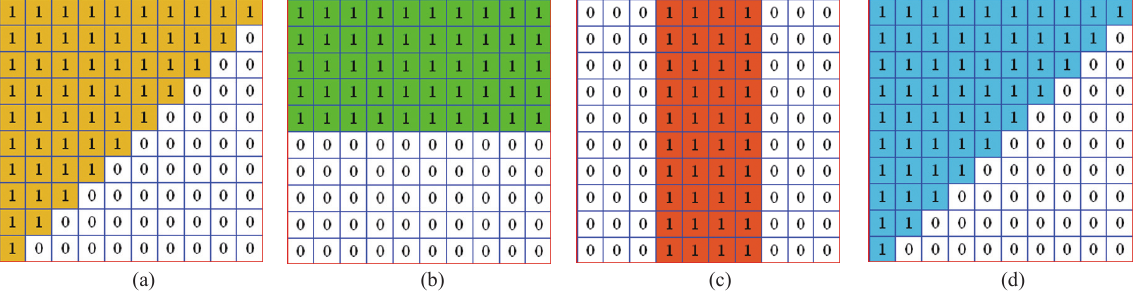
Fig. 3. Data gridding results of the fault template and the test sample (a) Sample 1 (b) Sample 2 (c) Sample 3 (d) Test